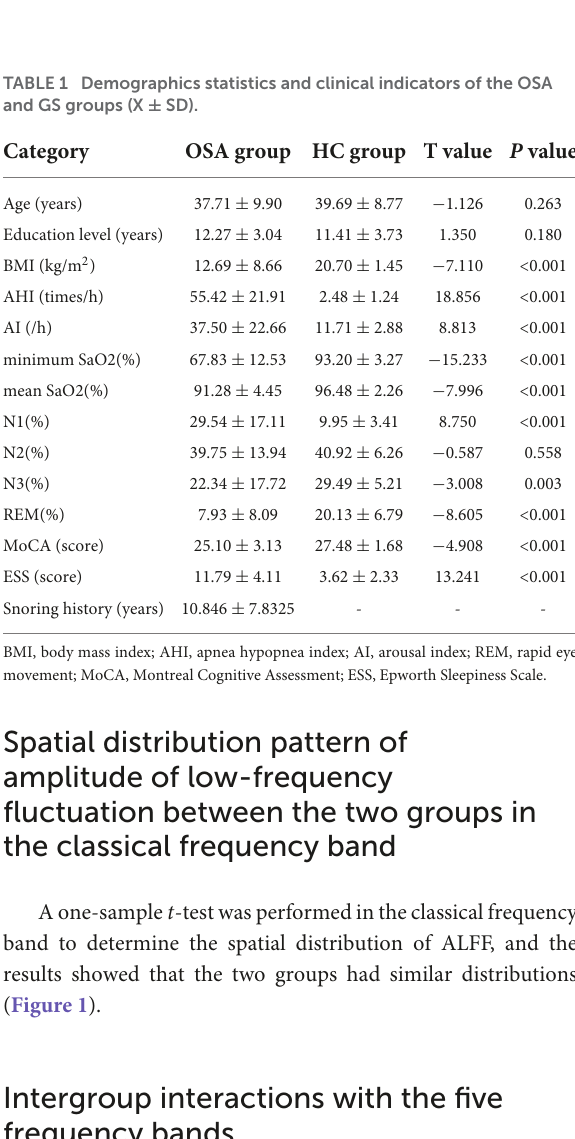
ANOVA analysis suggested a significant interaction